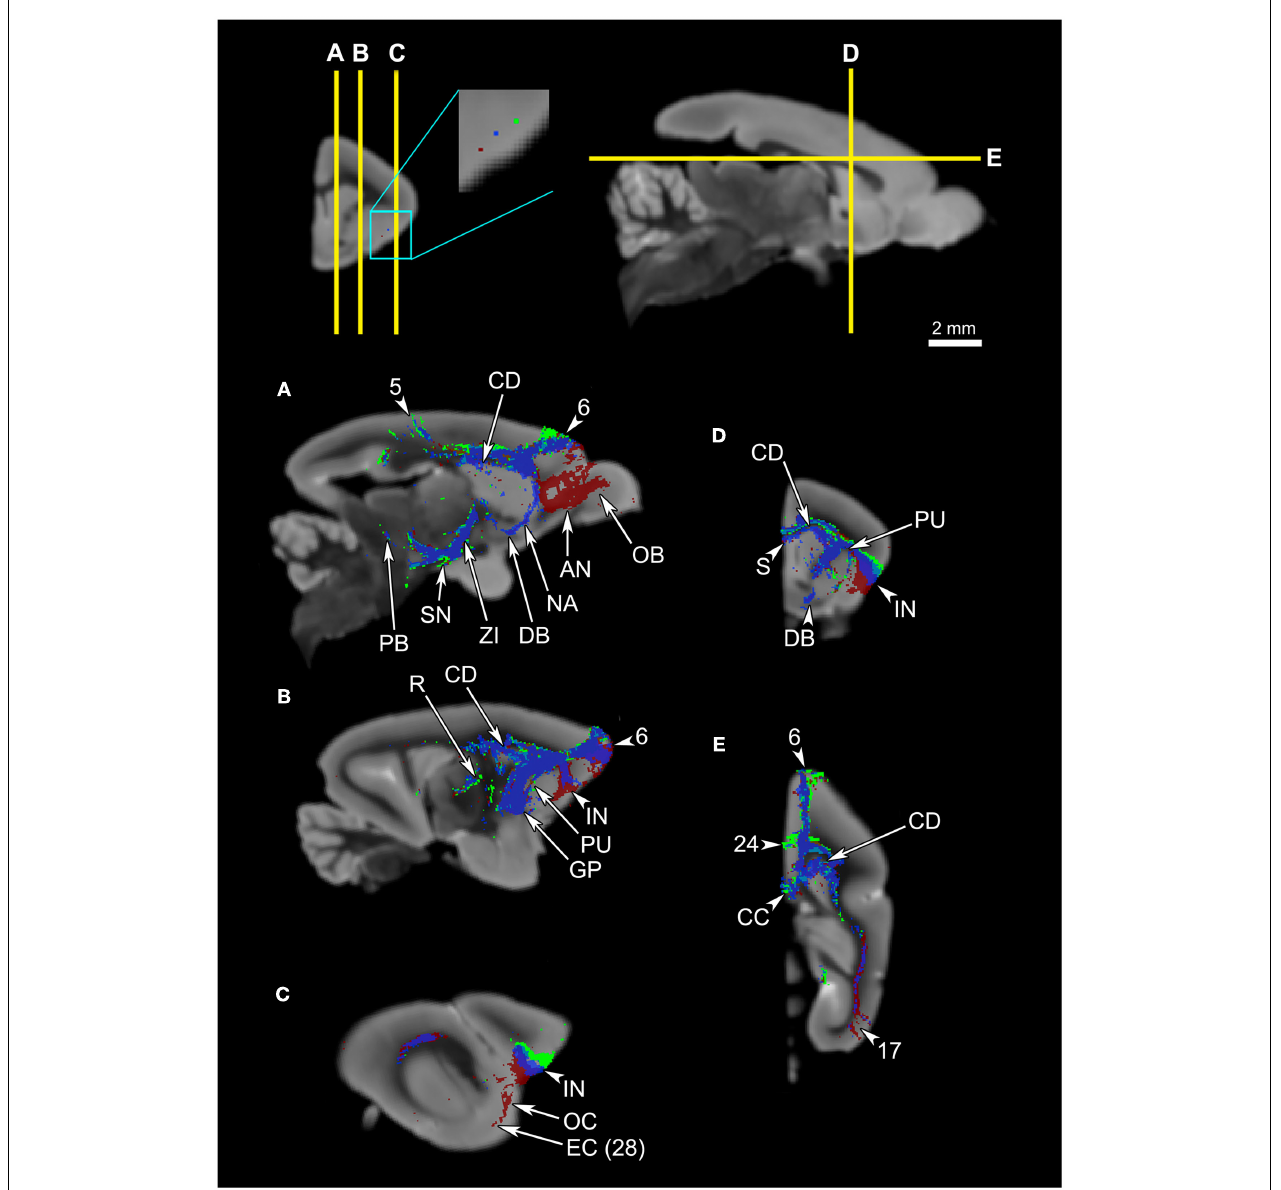
the connections to other olfactory structures likely arose from the agranular insula, rather than from the adjacent olfactory cortex. (D) shows the similarities between the middle insular tracts and the ventral insular tracts. Abbreviations: AN, anterior olfactory nucleus; CC, corpus callosum; CD, caudate; DB, diagonal band; EC, entorhinal cortex, Area 28 in Le Gros Clark’s (1931) cortical map; GP, globus pallidus; IN, insula; NA, nucleus accumbens; OB, olfactory bulb; OC, olfactory cortex; PB, parabrachial nucleus; PU, putamen; R, reticular thalamic nucleus; S, septum; SN, substantia nigra; ZI, zona incerta.The cortical area numbers are based on Le Gros Clark’s (1931) map of Microcebus